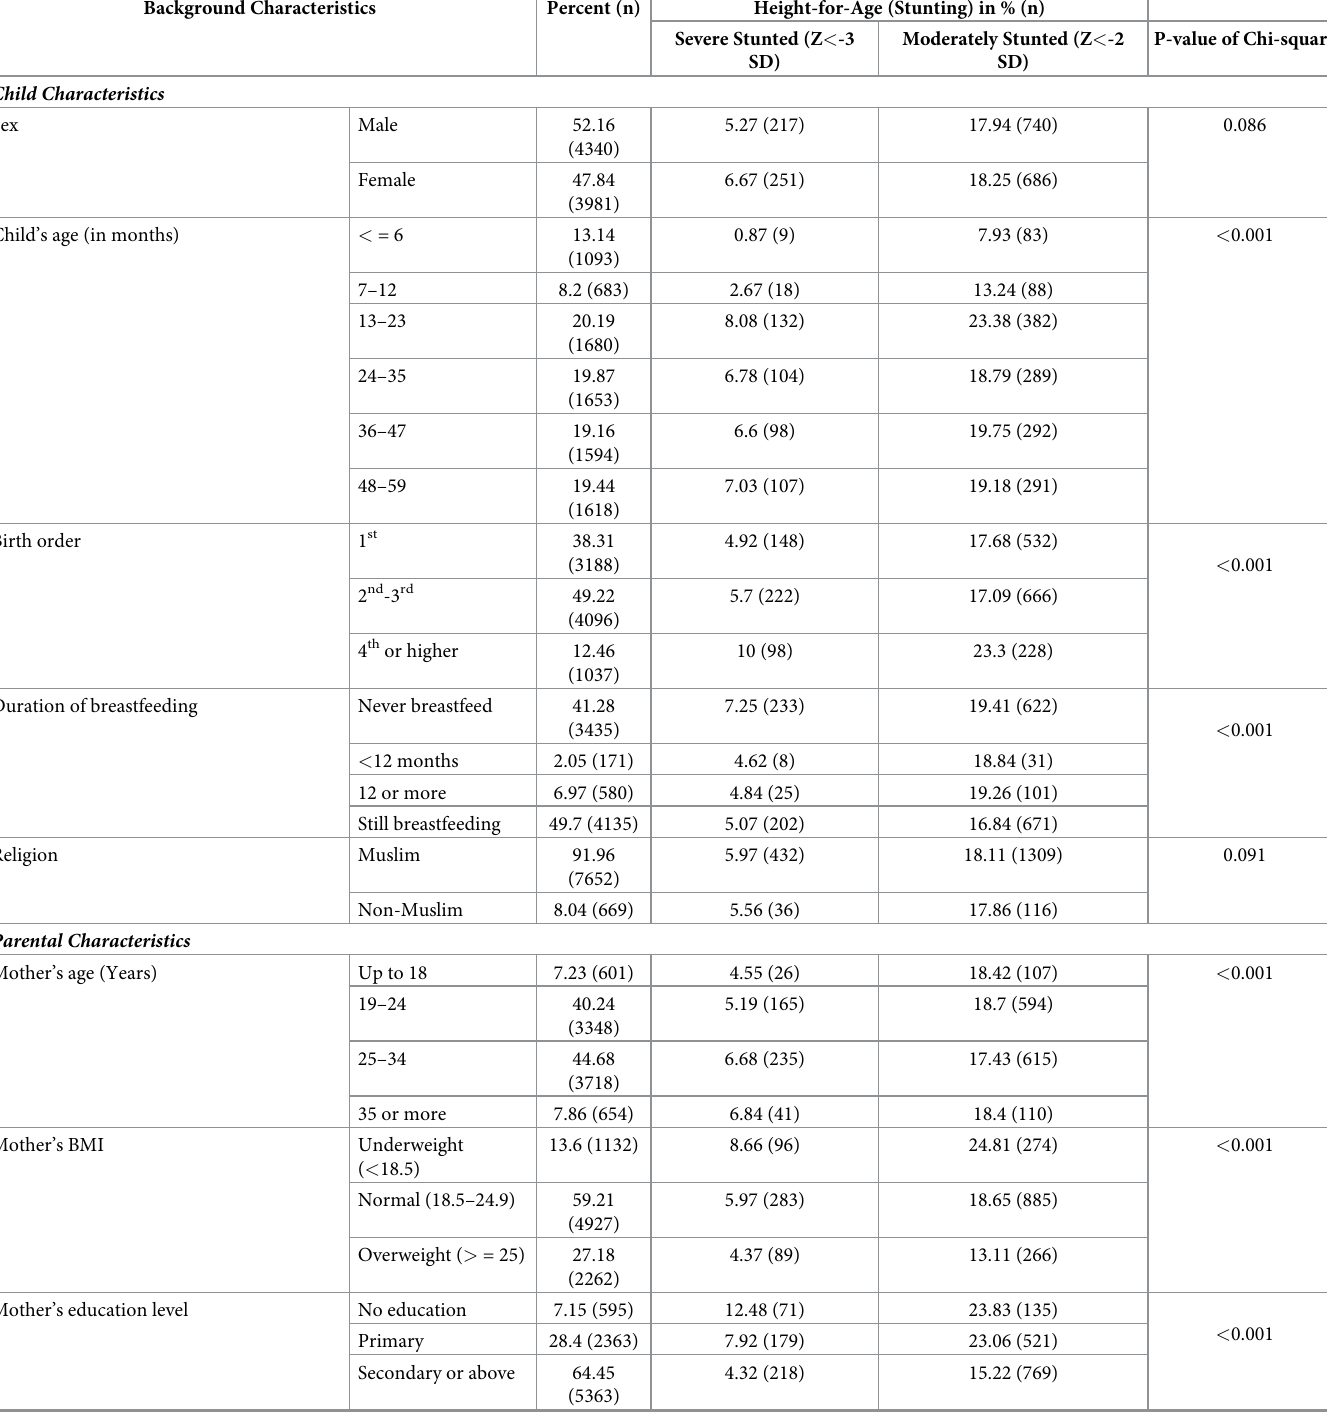
Table 1. Prevalence of child categorized according to the anthropometric index height–for–age (stunting) by selected characteristics, Bangladesh (BDHS 2017–18, n = 8,321). Background